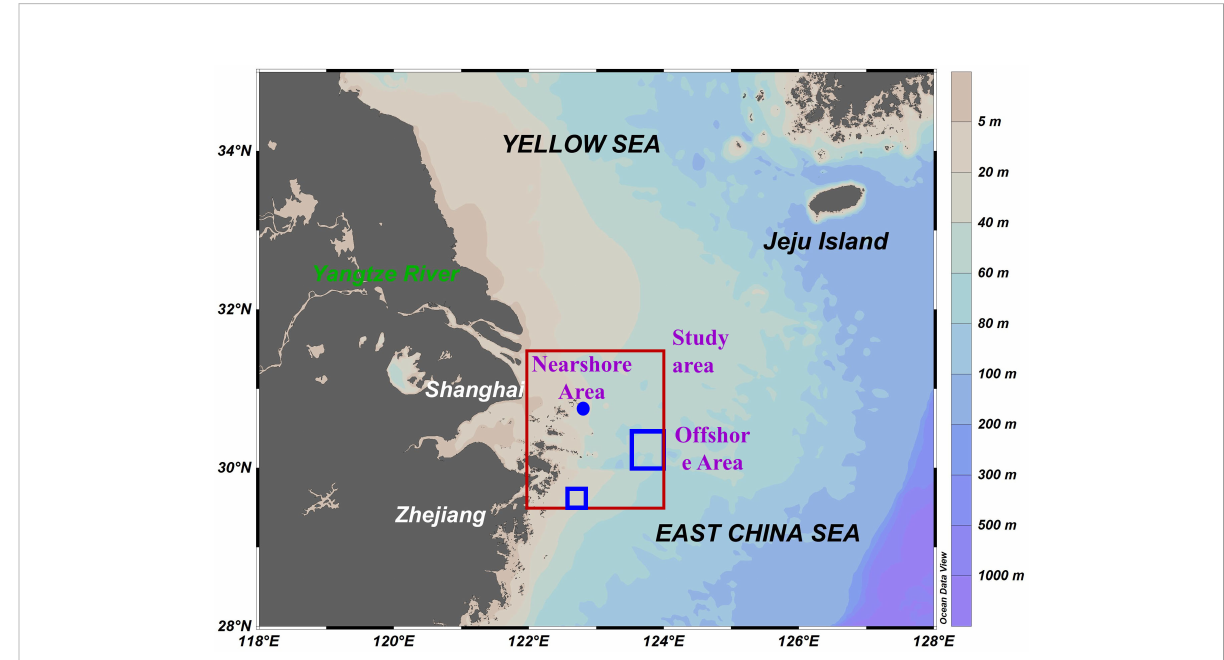
FIGURE 3 A map showing study sites. The red box indicates the entire research area in the paper. The blue dot marks the location of the mooring buoy, and the blue box represents the Offshore Area that is not affected by the plume and high turbidity. Bathymetry is shown from light to dark blue for the range of 5 to 2500